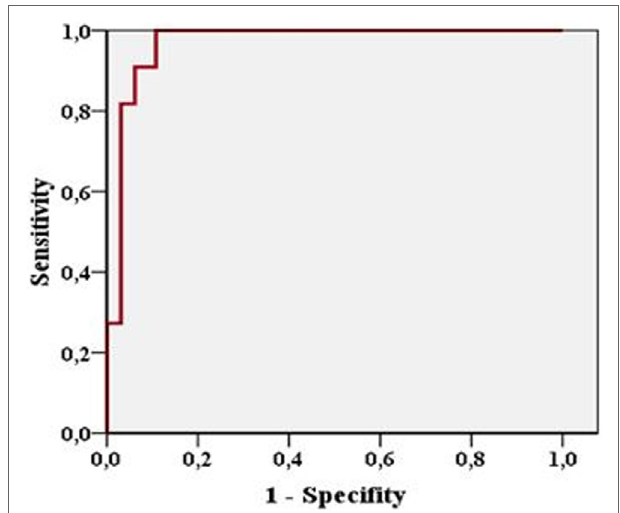
TaBle 1 | Patients’